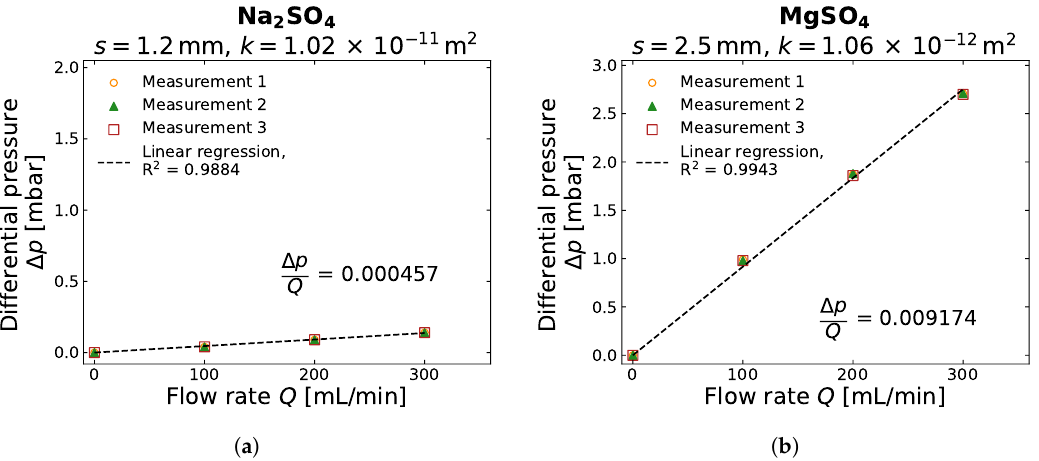
Figure 4. Pressure difference as a function of gas flow rate for two selected salt crusts (( a ) Na 2 SO 4 , ( b ) MgSO 4 ). The crust thickness s and the permeability k obtained with Equation (2) are provided in the title of each subplot.